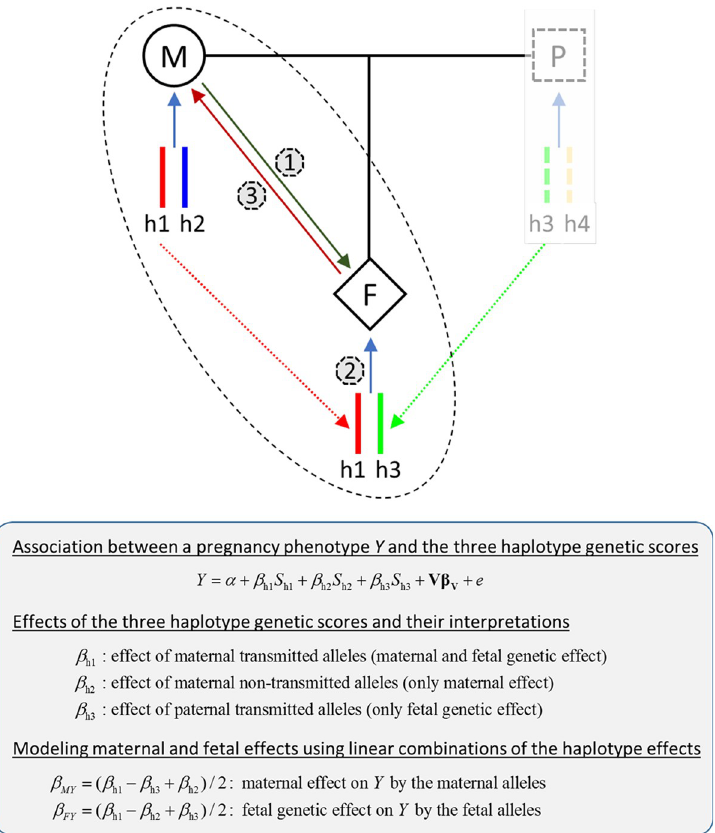
Fig 2. Genetic dissection of maternal and fetal genetic effects using haplotype genetic scores in mother–child pairs. There are 3 groups of alleles (haplotypes) in a mother (M)–fetus (F) duo: the maternal transmitted alleles (h1) can affect a pregnancy outcome through a maternal (1) and/or fetal genetic effect (2), the maternal nontransmitted alleles (h2) can only affect a pregnancy outcome through maternal effect (1), and the paternal transmitted alleles (h3) only through fetal effect (2) (assuming no paternal effect). The paternal transmitted alleles (h3) could influence a maternal phenotype during pregnancy by fetal drive (3). The paternal genetics might be able to influence maternal phenotype and pregnancy outcomes through the environment that the fathers create (i.e., paternal effect or “genetic nurture”). However, for the traits and their associated variants considered in this study (S2 Table), the paternal effects should be minimal and therefore were assumed to be